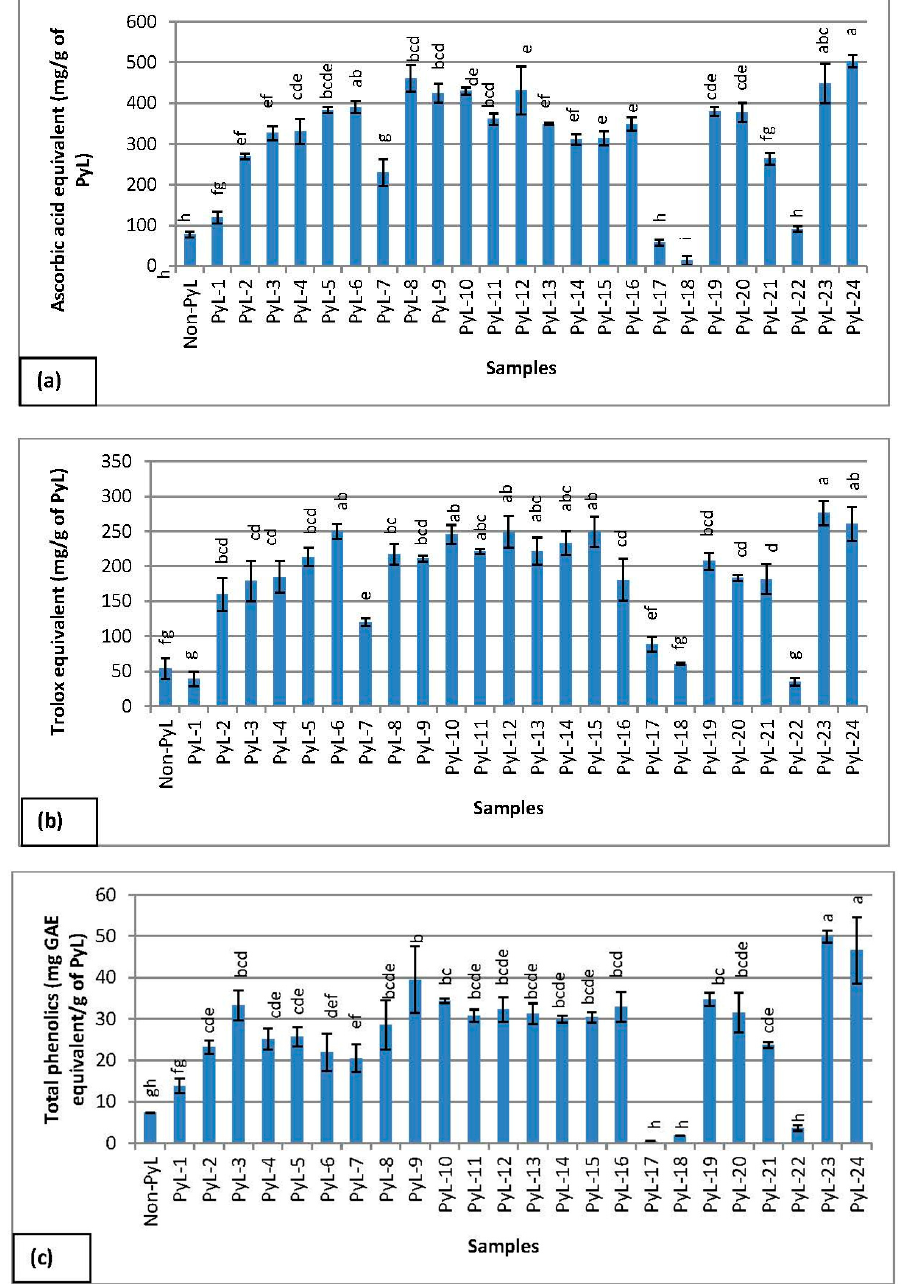
Figure 3. Antioxidant activity of pyrolytic lignins, as determined by ( a ) DPPH assay; ( b ) TEAC assay; and ( c ) total phenolics assay. Results are expressed: ( a ) mg ascorbic acid equivalents/g of pyrolytic lignin (PyL); ( b ) mg trolox equivalents/g of pyrolytic lignin (PyL); and ( c ) mg gallic acid equivalents (GAE)/g of pyrolytic lignin (PyL). Each value is presented as a mean ± SD ( n = 3). Analysis of variance was performed using one-way completely-randomized ANOVA (CoStat version 6.4) and means are separated using the Student-Newman-Keuls test ( p < 0.05). The bars with same alphabet superscript are not significantly different.